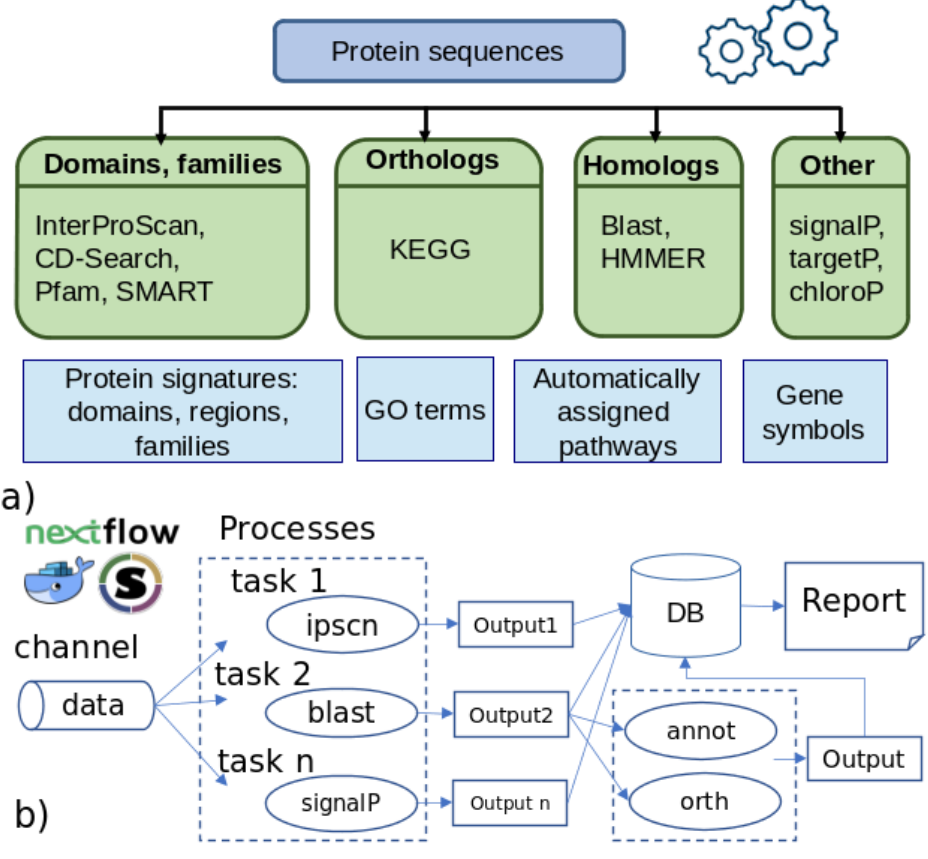
Figure 1. ( a ) A typical functional annotation workflow; ( b ) simplified flowchart of FA-nf pipeline.